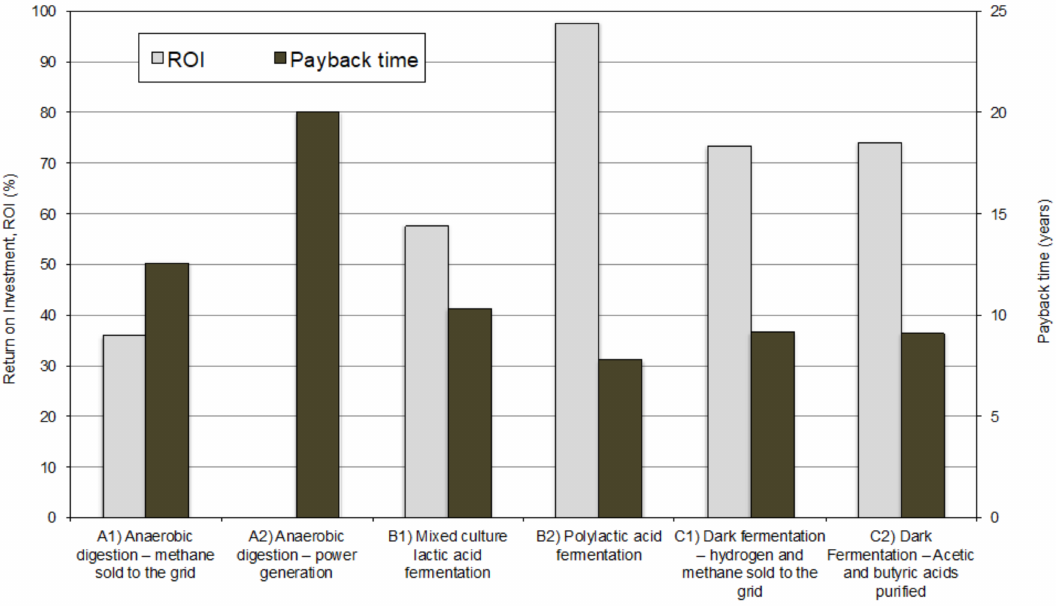
Figure 5. Return on investment (ROI) and payback time for the different assessed scenarios. All the scenarios where evaluated in a time frame of 20 years, with an annual interest of